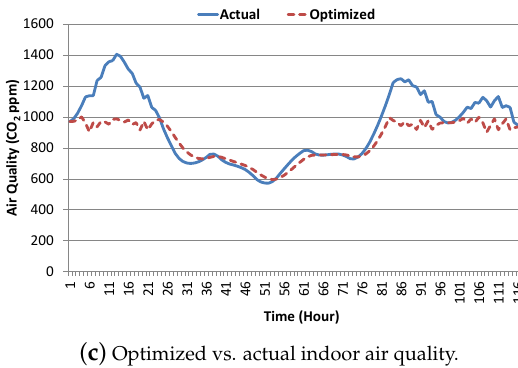
( a ) Optimized vs. actual indoor temperature. ( b ) Optimized vs. actual indoor illumination.